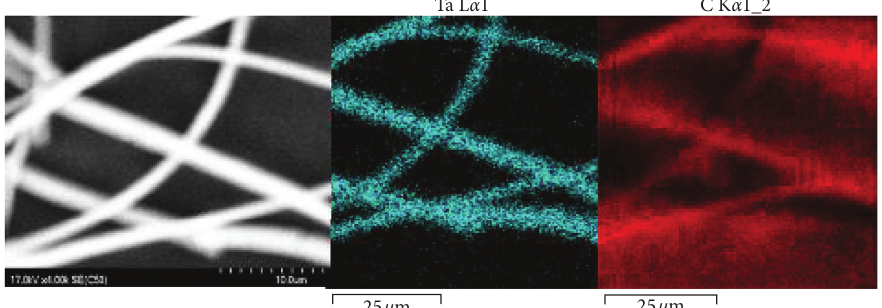
Figure 5: EDS analysis of as-spun TaC fibers after